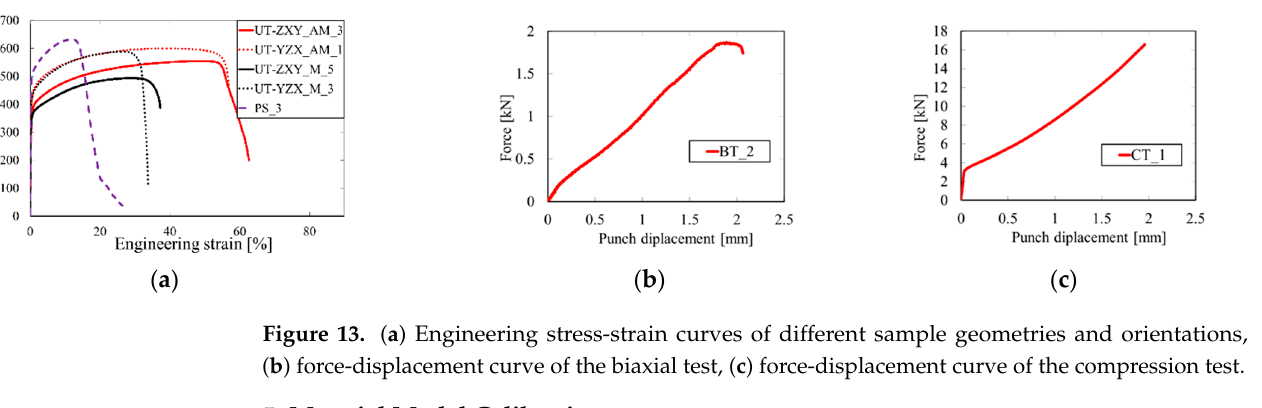
of the samples before and after testing, yield strength and ultimate tensile strength (if applicable).